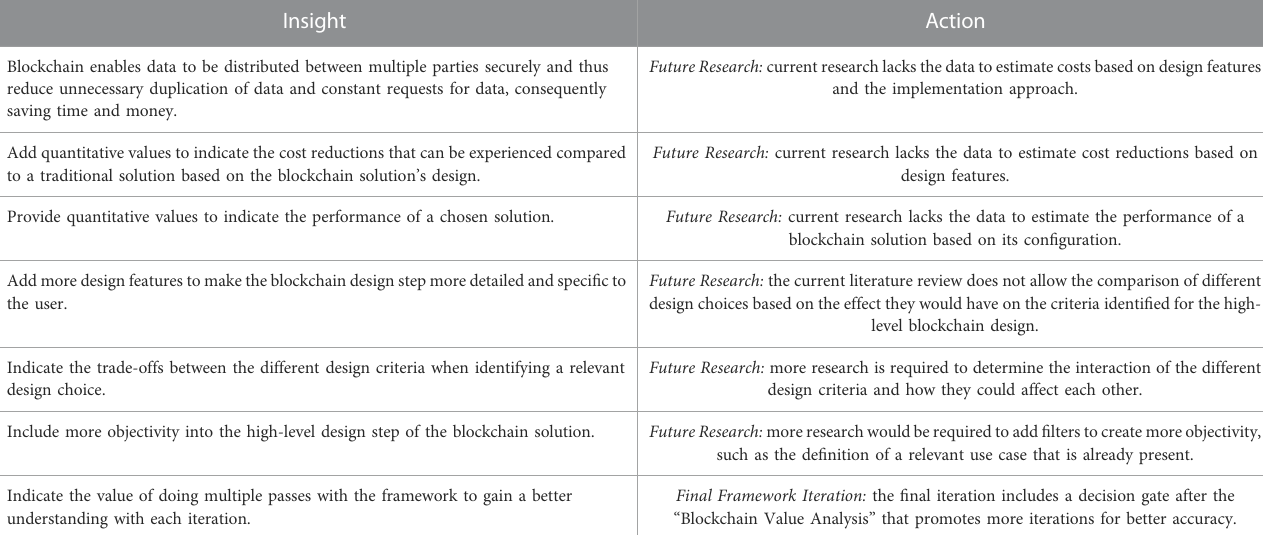
TABLE 9 Feedback Insights. Insight